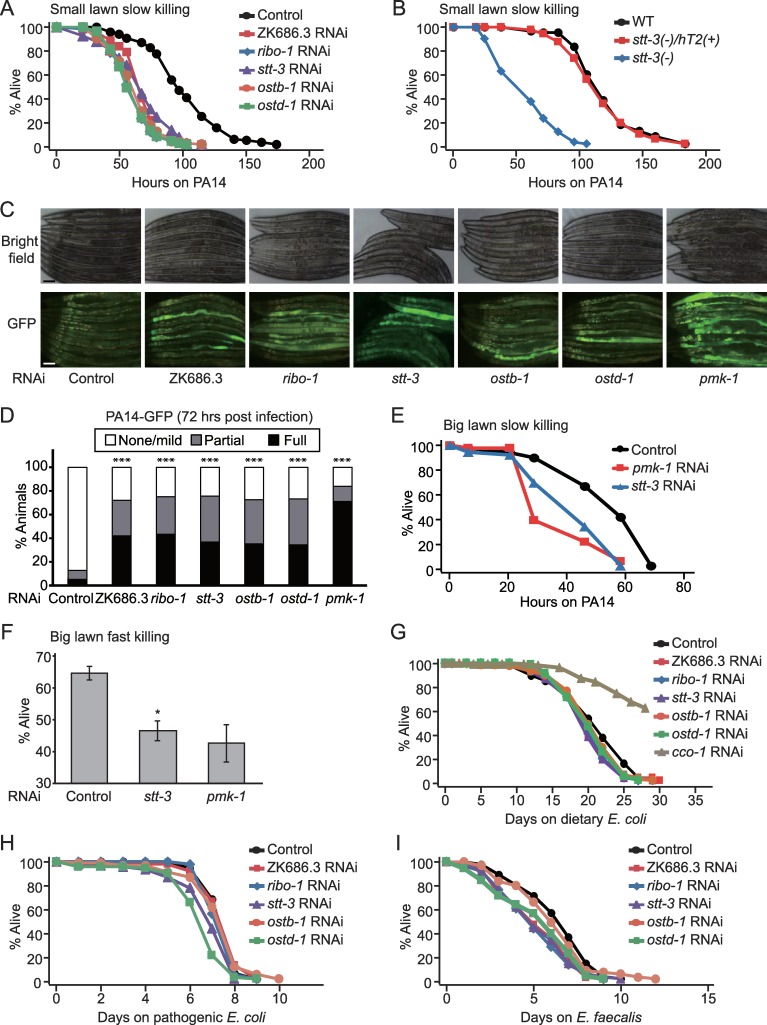
C. elegans OST complex is required for protection against and clearance of PA14.(A-B) Genetic inhibition of OST complex by RNAi targeting each component (ZK686.3, ribo-1, stt-3, ostb-1, or ostd-1) (A) or by a mutation in stt-3(syb458) [stt-3(-)] (B) reduced the survival of C. elegans under PA14-infected conditions. WT: wild-type (N2), stt-3(-)/hT2(+): a balanced heterozygote. We replaced 550th tyrosine residue in STT-3 with alanine for generating a reduction of function allele (S1C Fig), because the orthologous change (Y519A) in yeast STT3 caused mild growth defects without causing lethality [33]. stt-3(syb458) homozygotes were able to develop to L4/young adult stage but were sterile. These phenotypic observations suggest that stt-3(syb458) is a reduction of function allele. (C) Shown are representative images of worms that were pre-treated with control RNAi and RNAi targeting each indicated OST component, after PA14-GFP exposure for 72 hrs. pmk-1 RNAi was used as a positive control. Scale bar indicates 100 μm. (D) Semi-quantification of GFP-labeled PA14 levels in the intestinal lumen of worms in panel C (n ≥ 20 from two independent experiments). p values were calculated by using Chi-squared test (***p < 0.001). We also found that stt-3 RNAi slightly reduced pumping rates of worms (S1D Fig). Thus, the increased accumulation of PA14 by inhibition of OST seems unlikely due to increased PA14 uptake. (E-F) Inhibition of OST complex by stt-3 RNAi reduced the survival of worms both under slow (E) and fast killing (F) conditions of which the whole surface of plates was covered by PA14 (big lawn of PA14). (G) Perturbation of OST complex by RNAi targeting each of OST components had small effects on lifespan fed with normal dietary E. coli diets. RNAi targeting cco-1 (cytochrome c oxidase-1 subunit) that increases lifespan [83] was used as a positive control. (H) Knockdown of each of three components (ZK686.3, ribo-1, and ostb-1) of the OST complex did not alter the survival of worms upon infection with pathogenic E. coli. RNAi targeting stt-3 or ostd-1 slightly reduced the survival on pathogenic E. coli. (I) The survival time of worms treated with each of four OST components (ZK686.3, ribo-1, stt-3, and ostd-1) was variable under E. faecalis-infected conditions. See S3 Table for additional repeats and statistical analysis for survival assay results in this figure.